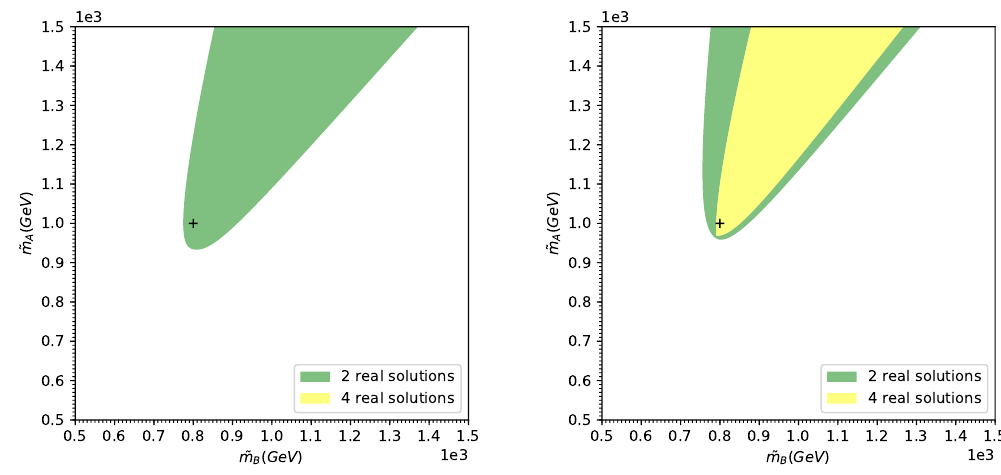
Figure 2 . Solvability plots for two di(cid:11)erent events, showing the number of solutions allowed by di(cid:11)erent values of ( ~ m ; ~ m ). The test mass ~ m has been (cid:12)xed to be the true mass, ~ m = m = B A C C C 700 GeV. Uncolored areas in the plots correspond to zero real solutions, while green (yellow) regions correspond to two (four) solutions. The cross marks the true mass point ( m ; m ). For the event B A on the left, the plot only shows an allowed region with 2 real solutions (the allowed region with four solutions is outside the plot range). For the event on the right, both a region with 2 solutions and a region with 4 solutions can be